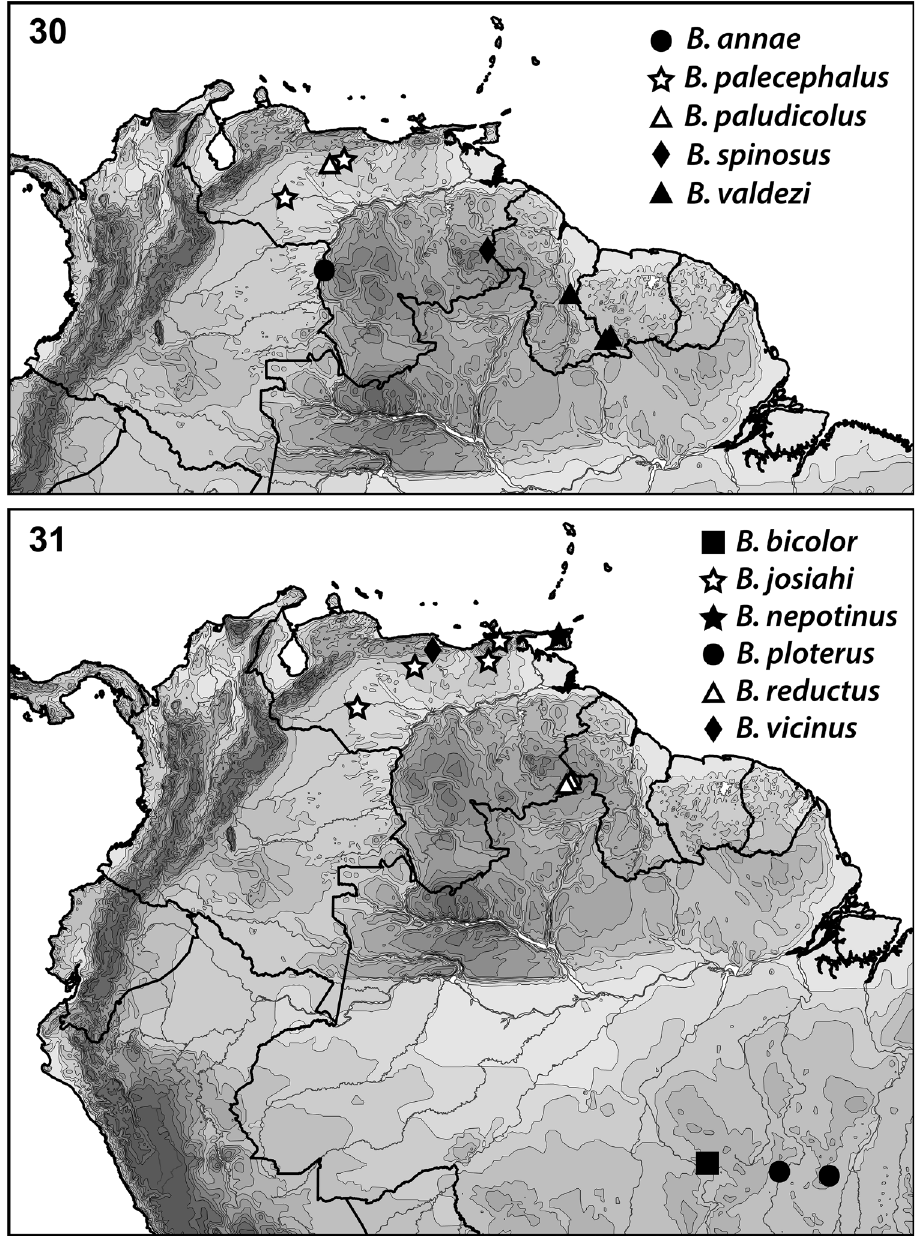
Figures 30–31. Bidessonotus species, South American